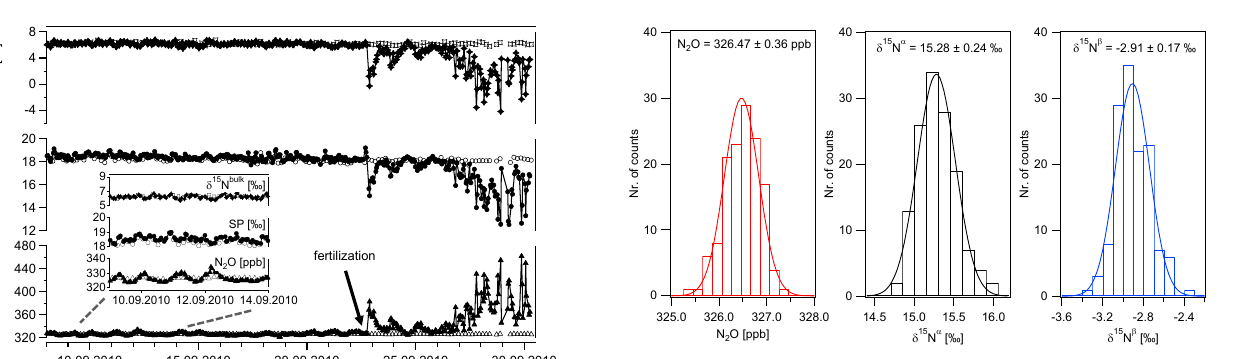
Fig. 4. Repeated measurements of pressurized air (target gas) dur- ing the field experiment. N 2 O mixing ratios and relative differences of isotope ratios were plotted as a histogram with bin widths of 0.25ppb (N 2 O), 0.15‰ ( δ 15 N α ) and 0.1‰ ( δ 15 N β ) , respectively (the precision indicated is the standard